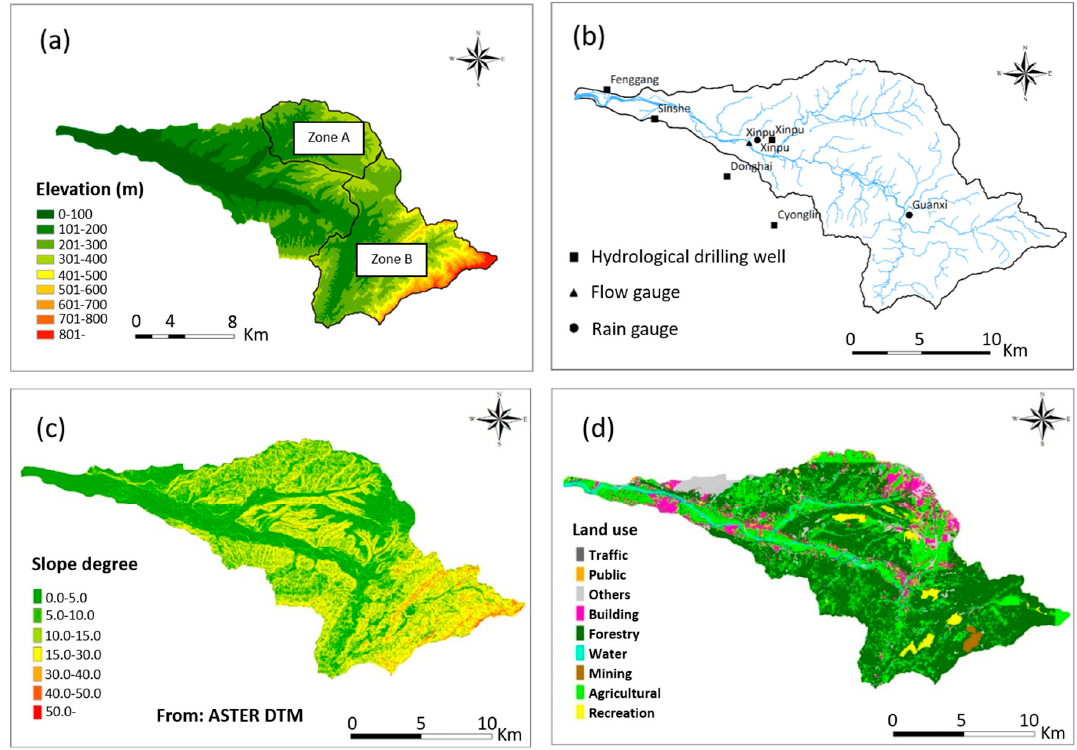
Figure 3. ( a ) Surface elevation of the Fengshan Creek basin, ( b ) gauge stations, ( c ) degree of slope, and ( d ) land use.